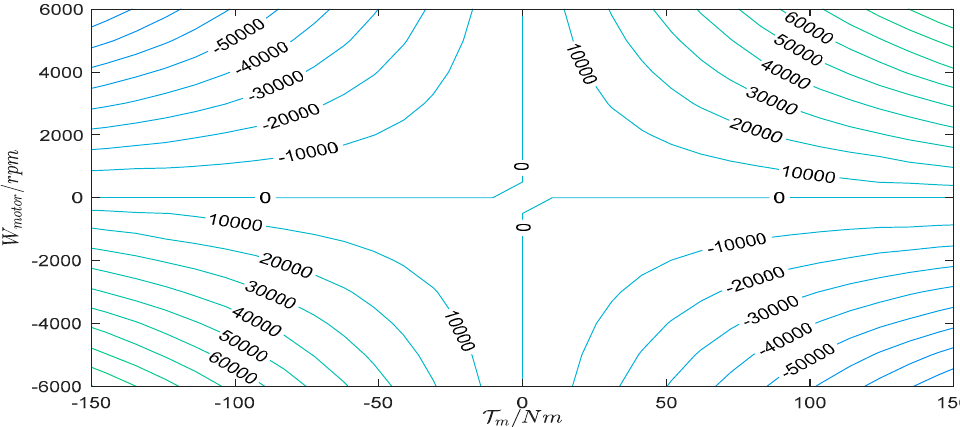
Figure 7. Equal power contours of an electric motor. The solid lines represent P m ( W ) based on the dimensional polynomial by fitting.